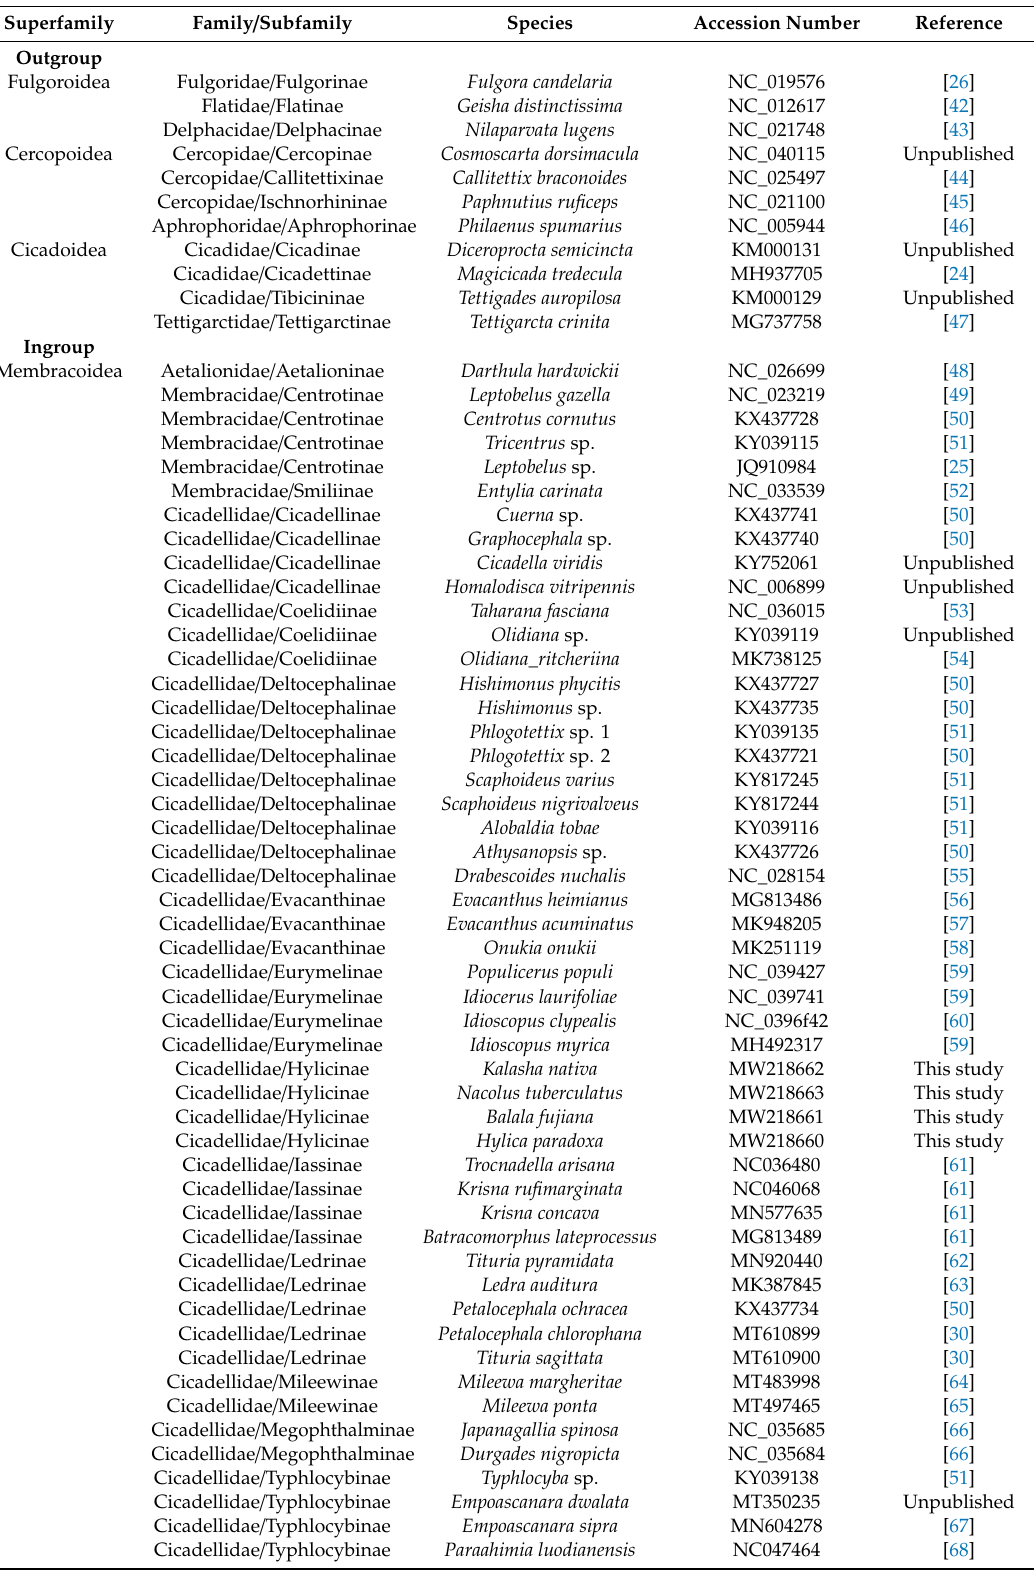
Table 1. Information of samples for phylogenetic